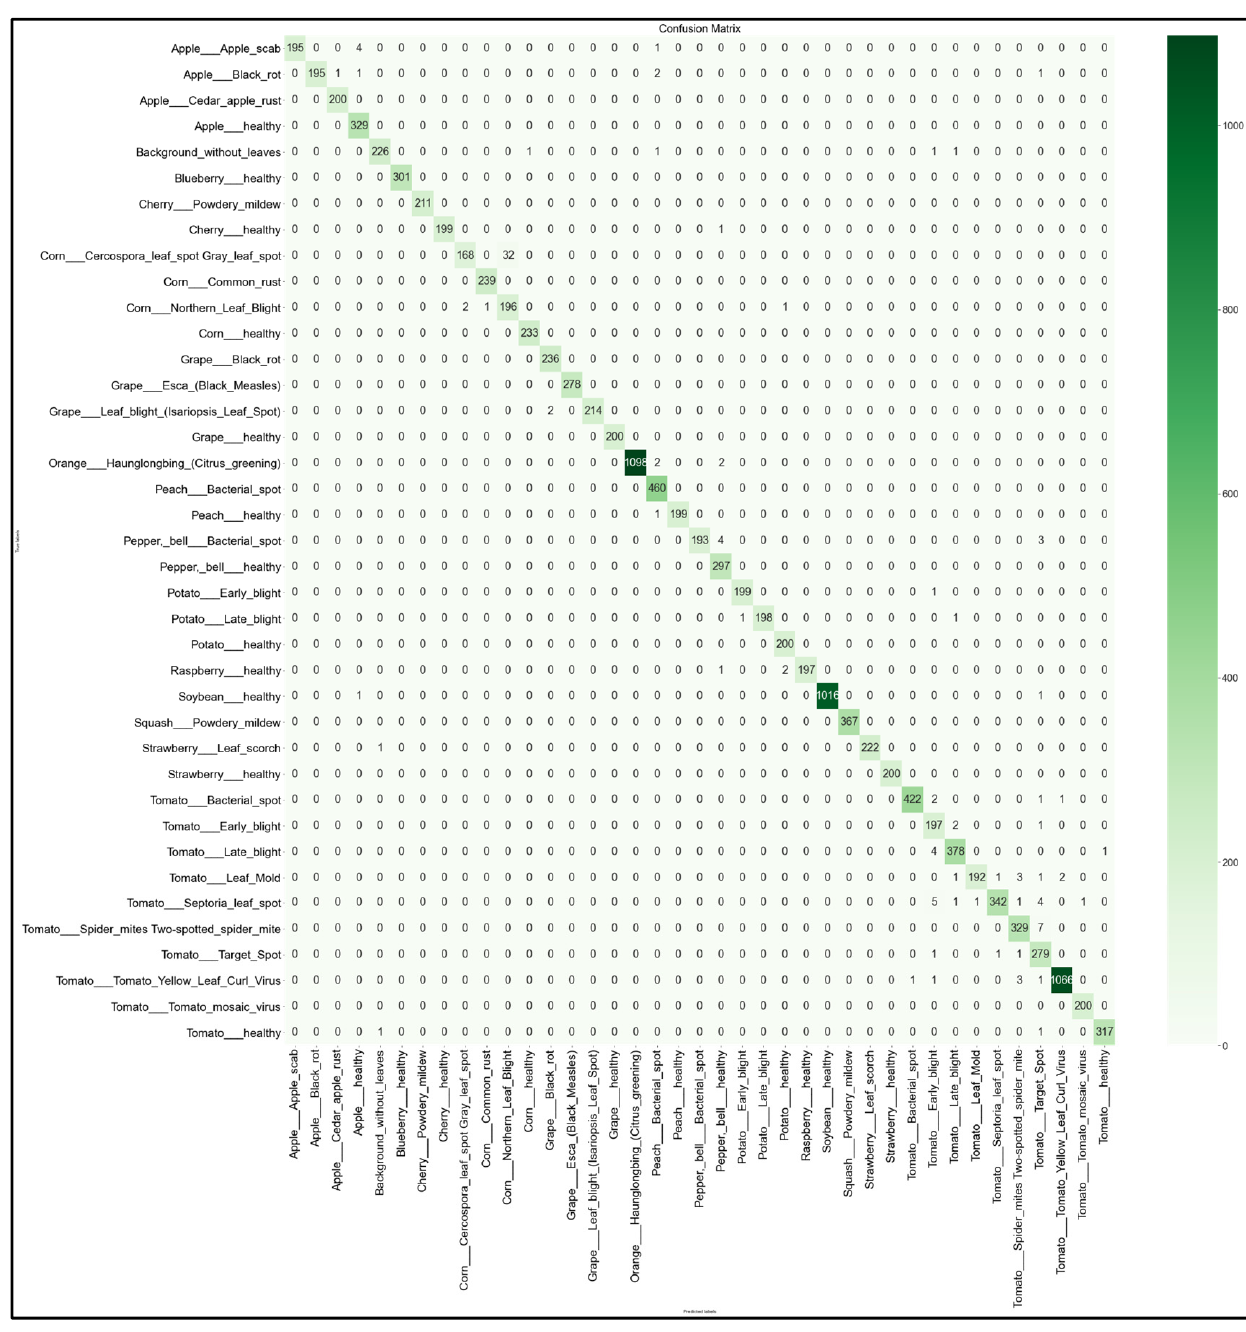
Figure 17. 39 × 39 Confusion matrix for the NasNetMobile model with transfer learning Scenario 3 and the Proposed hyperparameters.